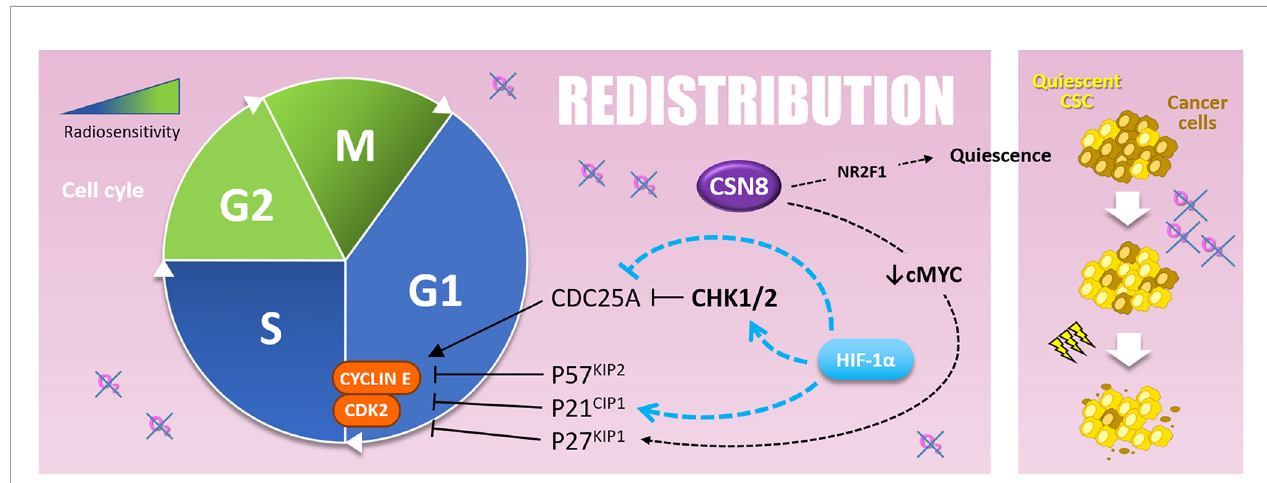
FIGURE 6 | Redistribution. Cells are more resistant to radiotherapy in the G1 and, above all, in the S phase of the cell cycle. The G1-S transition is notably driven by the Cyclin E and CDK2, inhibited by P57 KIP2 , P21 CIP1 , and P27 KIP1 . Hypoxia upregulates P57 KIP2 and P27 KIP1 as well as P21 CIP1 in a HIF-1 a dependent manner. The overexpression of CSN8 correlates with cMYC decrease and P27 KIP1 expression. It also correlates with NR2F1 quiescence marker expression. Quiescent CSC, selected by hypoxic stress, are more resistant to irradiation and participate in radioresistance (right